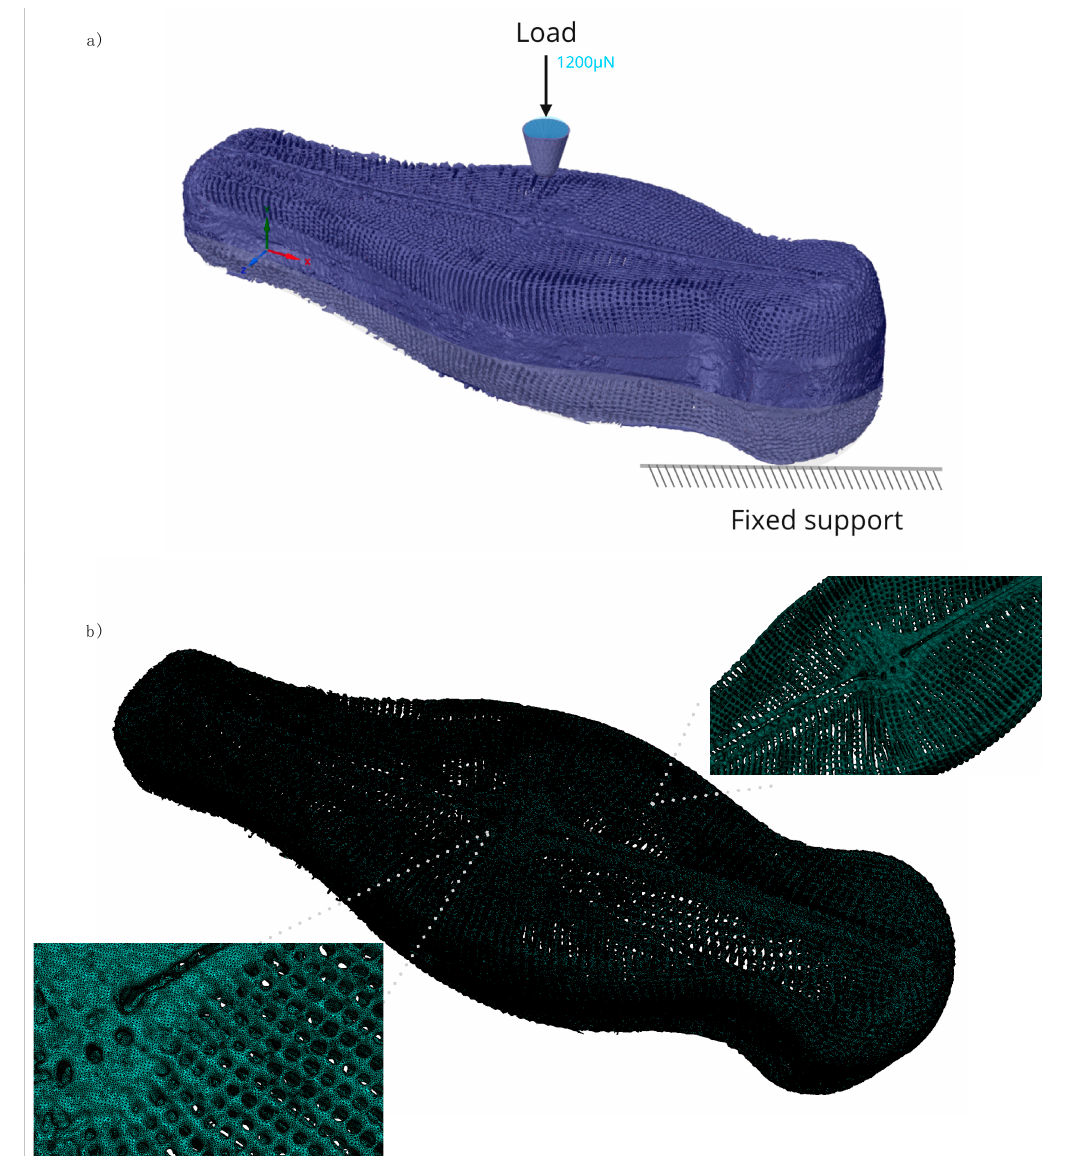
Figure 8. Finite element analysis model of the Didymosphenia geminata frustule: ( a ) boundary conditions used for replication of in situ micro-indentation experiments, ( b ) final FEM mesh used for the simulations that consists of 21.6 million tetrahedral elements and 1.2 million hexahedral elements with an average mesh quality of 0.95.